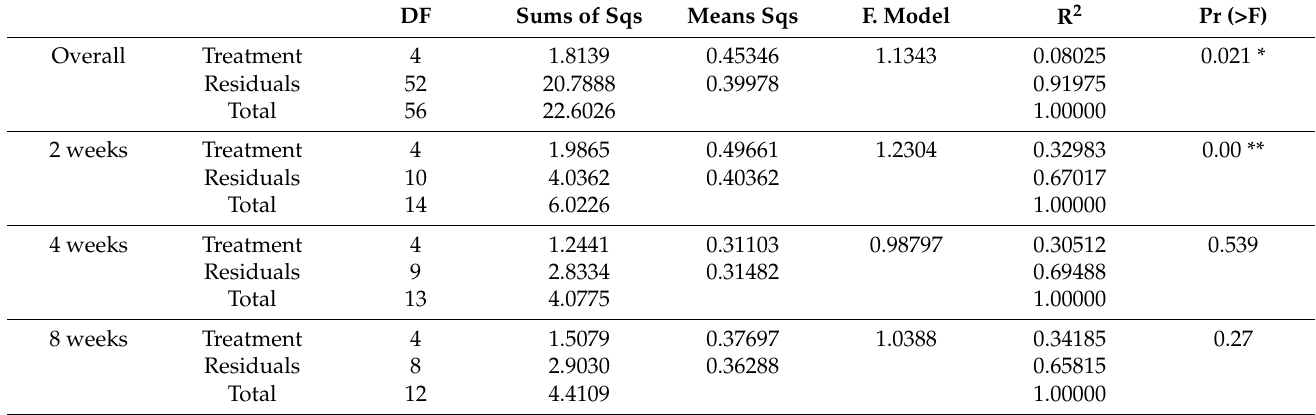
Figure 4. Boxplot of the Bray–Curtis dissimilarity for different samples across different sampling time points. The first plot shows the difference along the PCoA1 plane, while the second plot shows the difference along the PCoA2 plane. The dark blue color shows the total alpha diversity for the C8 samples, while the red, green, light blue, and purple colors signify the C10, C12, BS, and W samples, respectively. The significance values were generated according to one-way ANOVA with Duncan’s multiple range test values ( p < 0.05). Table 2. PERMANOVA analysis using Adonis during the overall and different sampling points using Bray–Curtis dissimi- larity distance values between N -acyl homoserine lactone treatments (C8, C10, C12) and the continuously mono-cropped ginseng soil